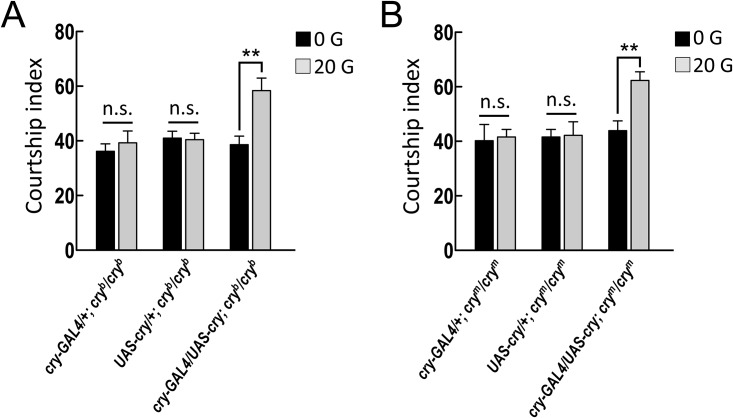
Expression of cryptochrome (CRY) with cry-GAL4 restores the increase in courtship activity in cry mutants in a magnetic field.(A) In the 20-G magnetic field environment, overexpression of the cry transgene in cry-GAL4-positive neurons restored the increase in courtship activity (indicated by courtship index) that was observed in flies with the cryb background, compared with the 0-G control. Each value represents the mean + SEM (n ≥ 9; **p < 0.01; n.s., not statistically significant; t-tests). Genotypes: (1) w/Y; cry-GAL4/+; cryb/cryb, (2) w/Y; +/UAS-cry; cryb/cryb, (3) w/Y; cry-GAL4/UAS-cry; cryb/cryb. (B) In the 20-G magnetic field, overexpression of the cry transgene in cry-GAL4-positive neurons restored the increase in courtship index that was observed in flies with the crym background compared with the 0-G control. Each value represents the mean + SEM (n ≥ 12; **p < 0.01; n.s., not statistically significant; t-tests). Genotypes: (1) w/Y; cry-GAL4/+; crym/crym, (2) w/Y; +/UAS-cry; crym/crym, (3) w/Y; cry-GAL4/UAS-cry; crym/crym.